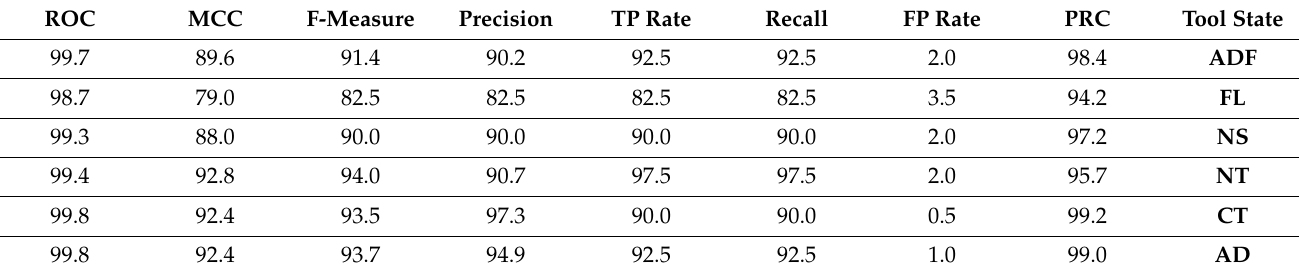
Table 9. Performance indicators of classification considering blind